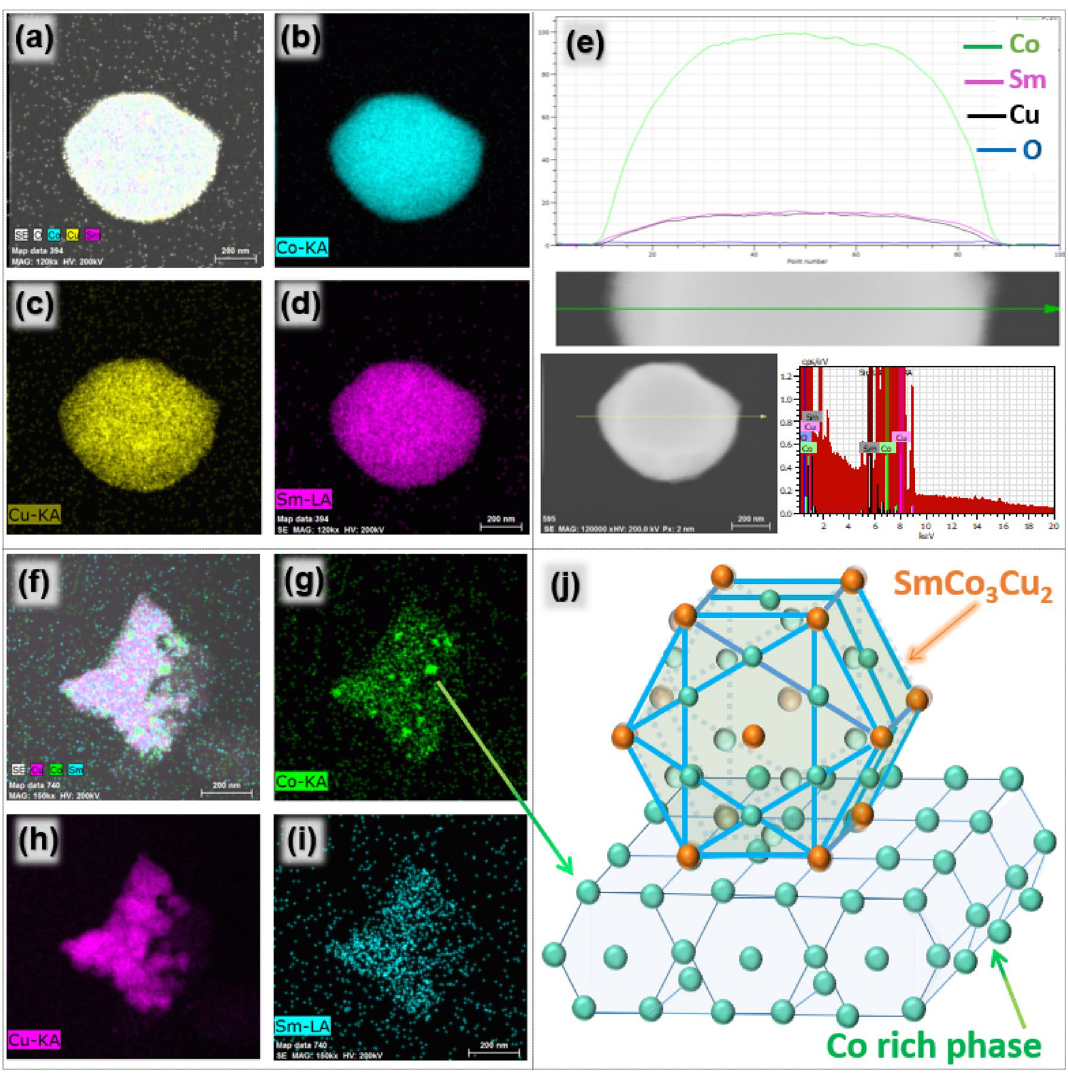
Figure 2. ( a – d ) TEM-EDS mapping images and ( e ) EDS line analysis of SmCo 4 Cu. ( f – i ) TEM-EDS mapping images SmCo 3 Cu 2 and ( j ) schematic illustration of Co attachment on SmCo 3 Cu 2